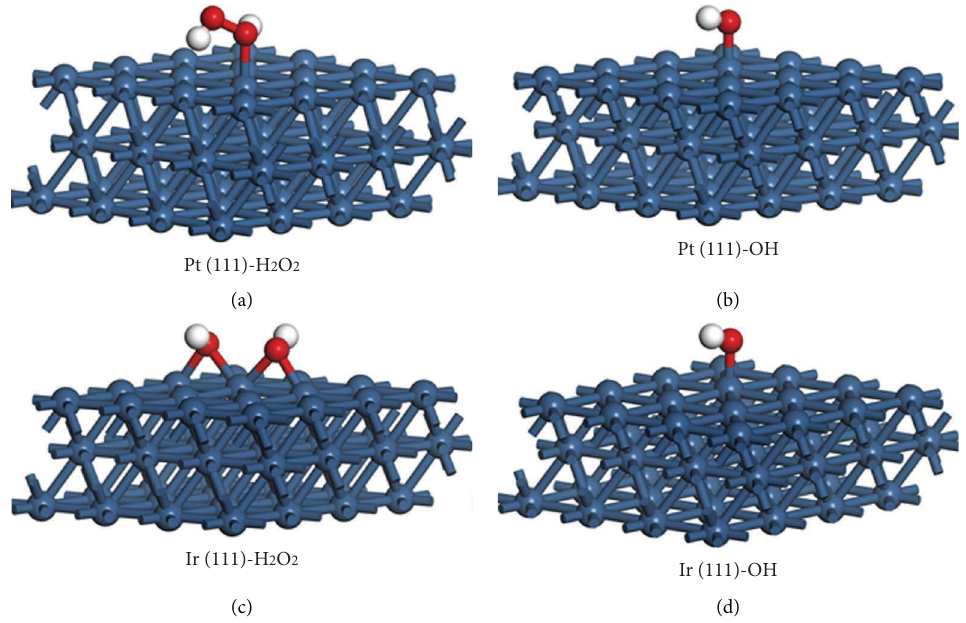
Figure 6: Te calculation model of H 2 O 2 on Pt (111) (a). Te calculation model of OH on Pt (111) (b). Te calculation model of H 2 O 2 on Ir (111) (c). Te calculation model of OH on Pt (111)